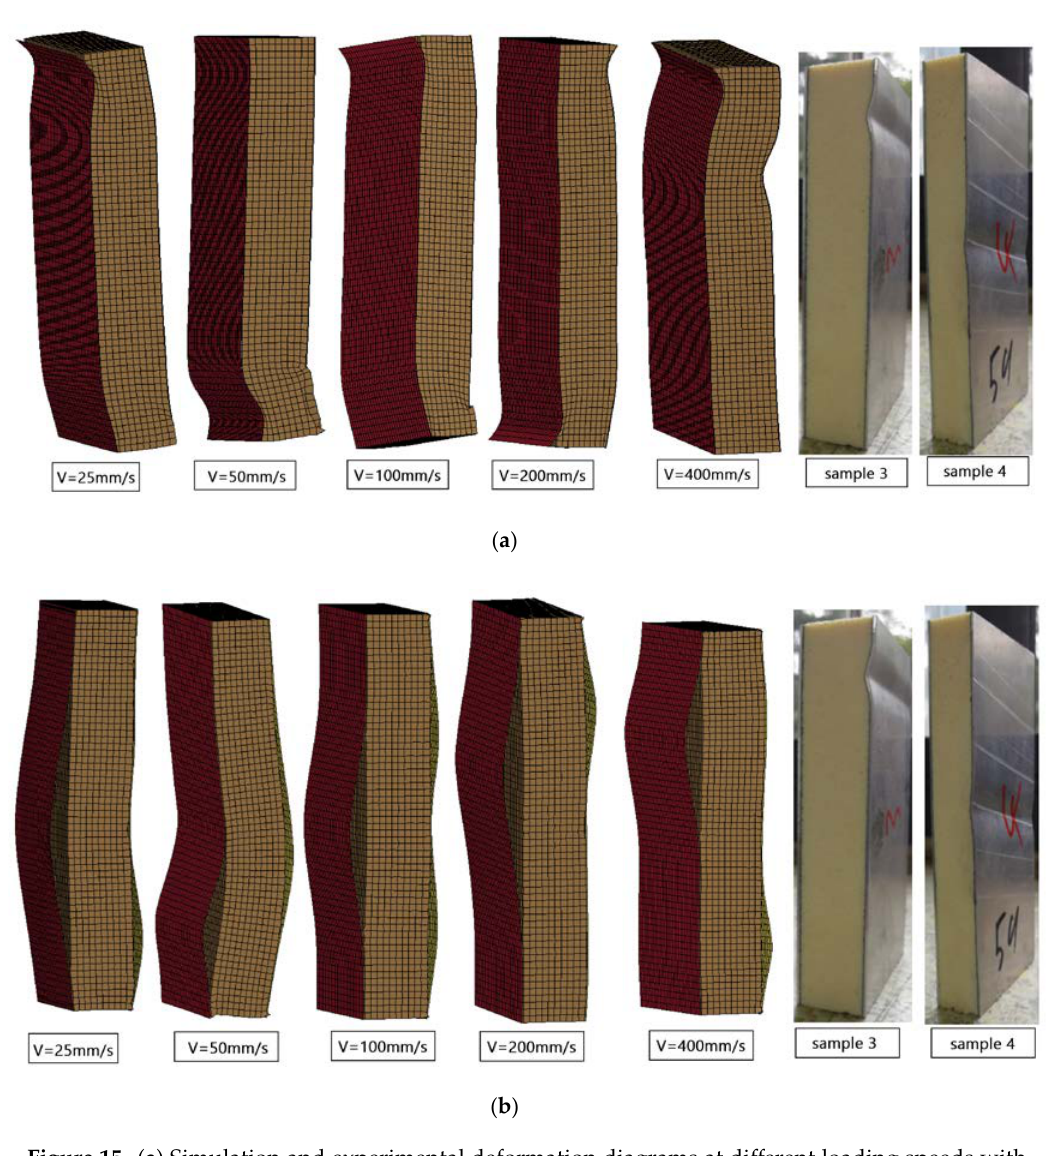
Figure 15. ( a ) Simulation and experimental deformation diagrams at different loading speeds with MAT 185 and ( b ) simulation and experimental deformation diagrams at different loading speeds with tiebreak contact.